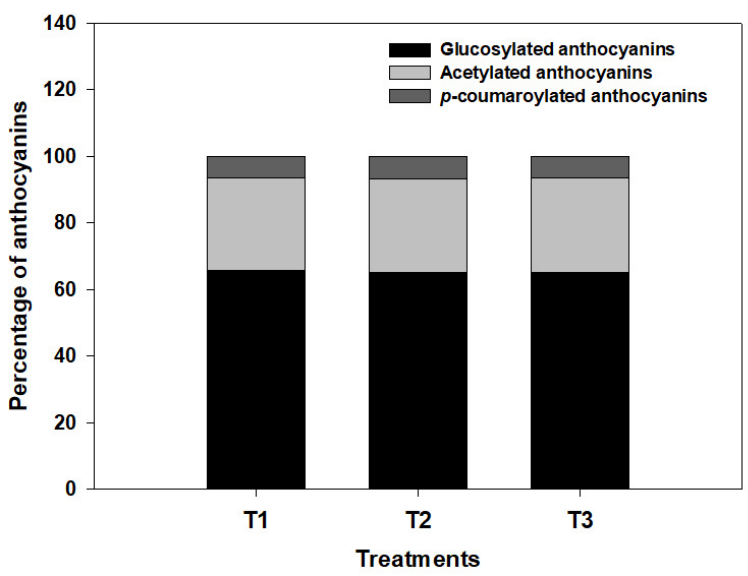
Figure 4. Proportion of glucosylated, acetylated and p -coumaroylated anthocyanins in Cabernet Sauvignon grape skins at harvest date. Different letters indicate significant differences between treatments (Tukey’s HSD test, p < 0.05).